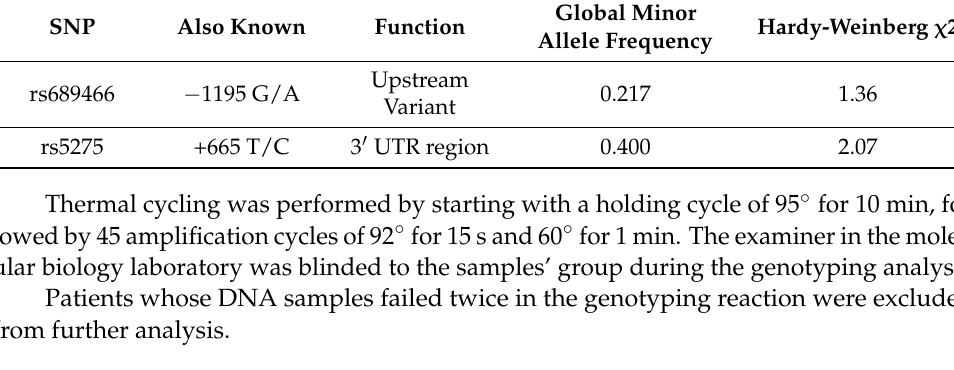
Table 1. Description of the studied SNPs in COX2 gene. SNP Also Known Function rs689466 − 1195 G/A rs5275 +665 T/C 3 (cid:48) UTR region 0.400